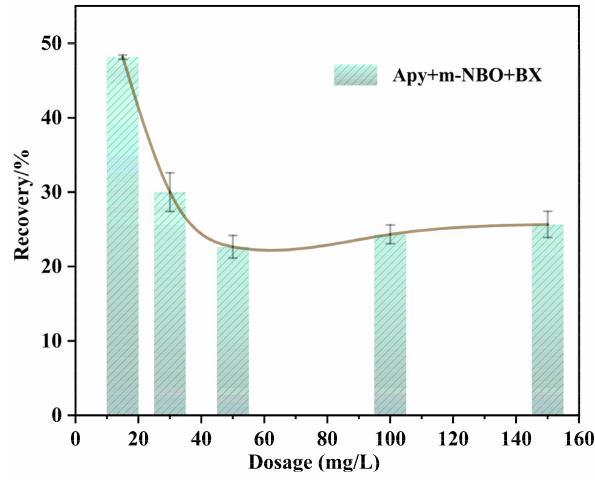
Figure 2. Effect of m-NBO dosage on the floatability of arsenopyrite, and error bar; C(NaBX) = 1.6 × 10 − 3 mol · L − 1 , and pH = 11.5.